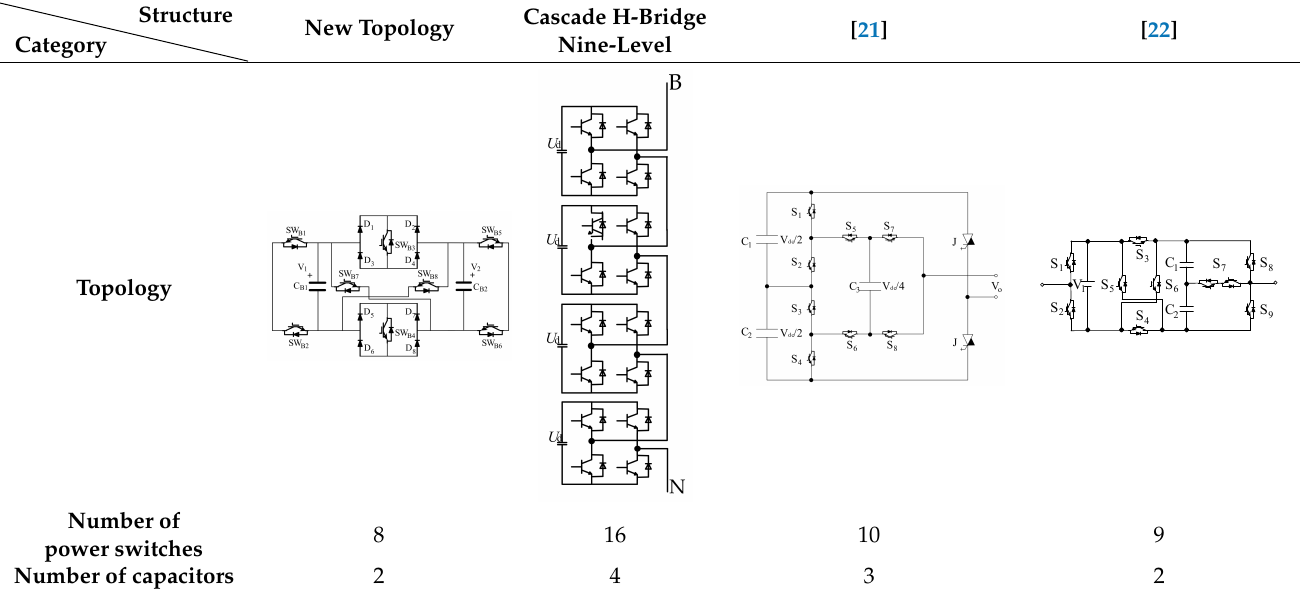
Table 2. Comparison of nine-level topology.